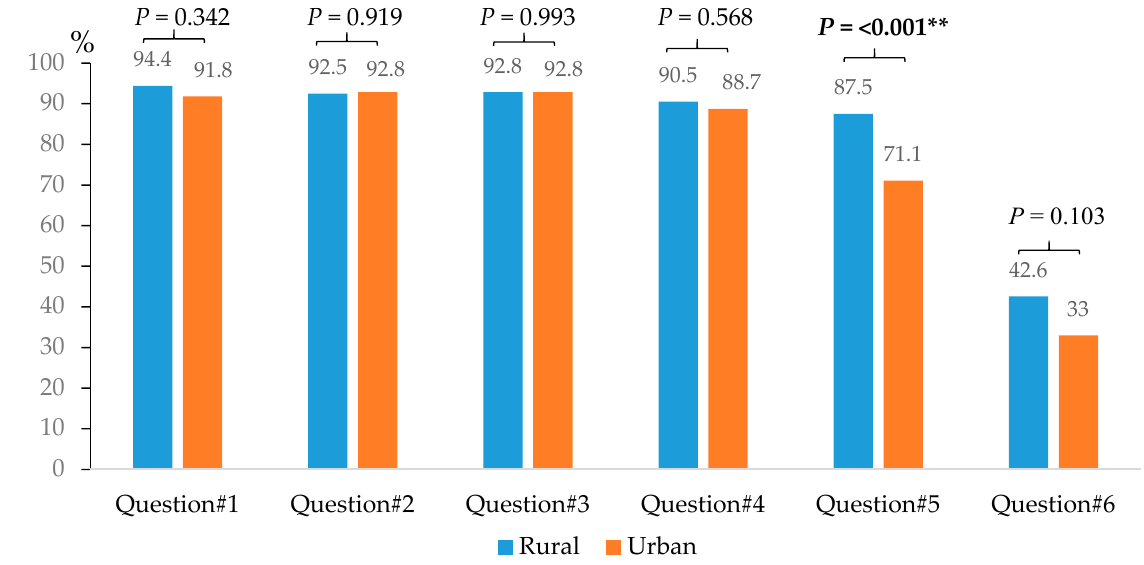
Figure 3. Attitude of consumers regarding pesticide residues in VF, ** p value < 0.01. Question #1.